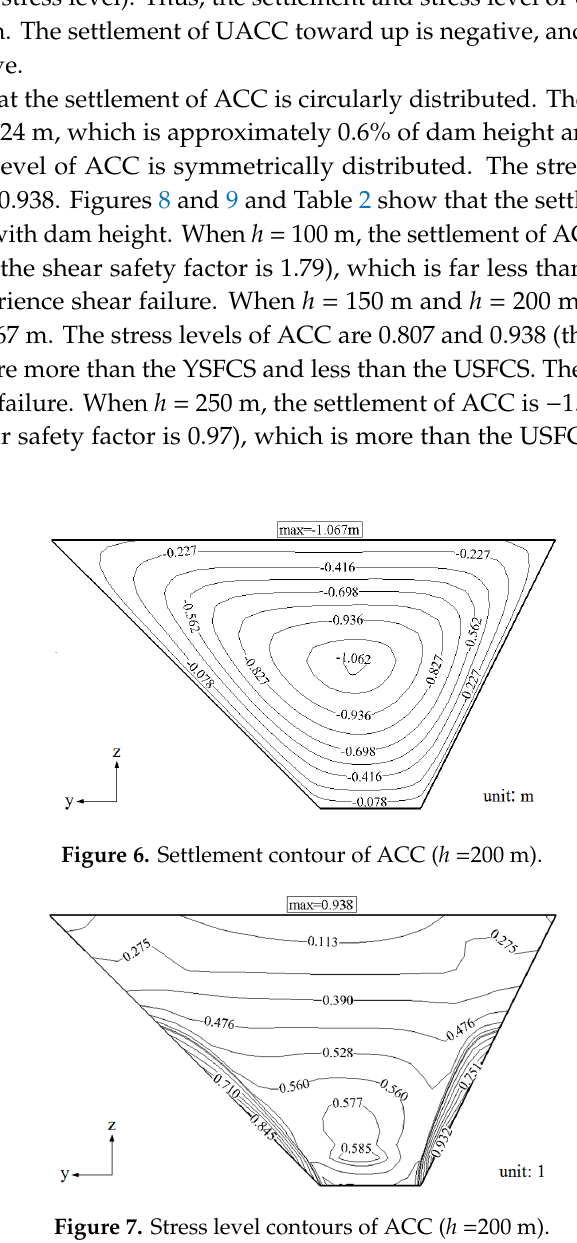
Figure 8. Relationship between settlement maximum of ACC and dam height .